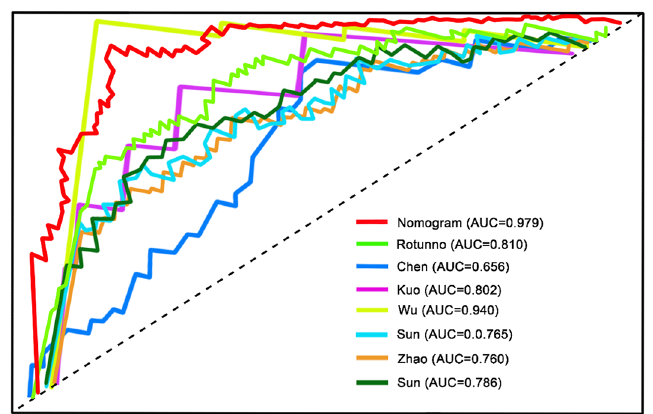
Figure 9. ROC curves illustrated the effectiveness of the methylation-related nomogram and a few known biomarkers in predicting the prognosis of stage I–II LUAD patients. The AUC in Rotunno et al. is 0.810, in Chen et al. (0.656), in Kuo et al. (0.802), in Wu et al. (0.940), in Sun et al. (0.765), in Zhao et al. (0.760), in Sun et al.